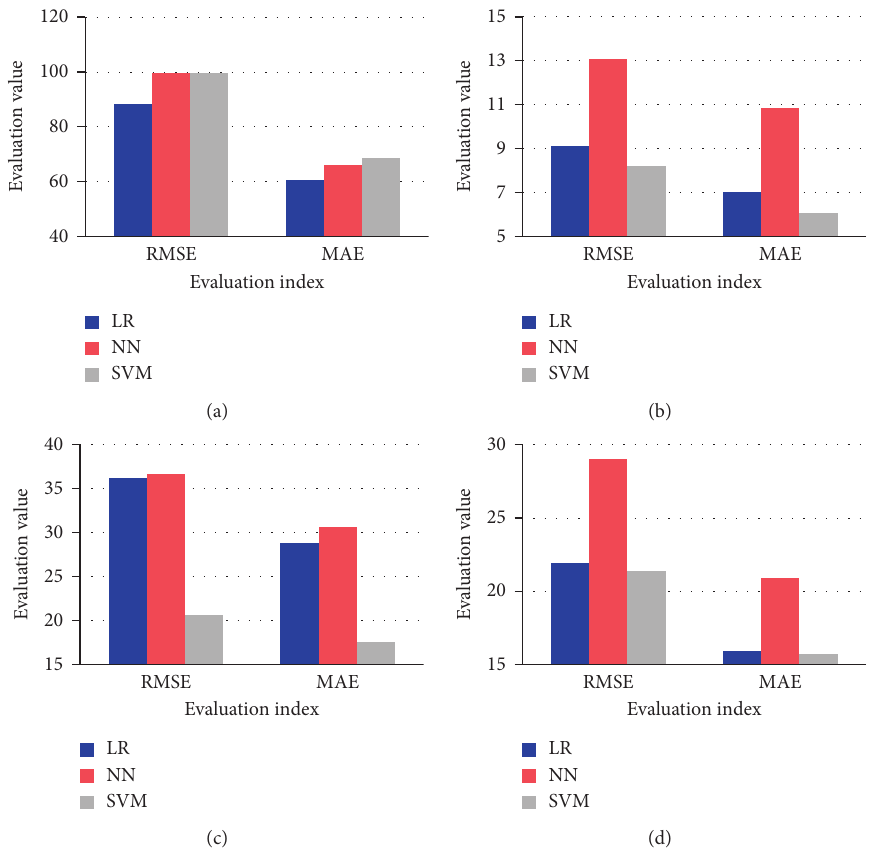
Figure 6: Comparison among the four prediction models using FM2. (a) Forecasting result of commercial parks using FM2. (b) Forecasting result of office parks using FM2. (c) Forecasting result of small-scale parks using FM2. (d) Forecasting result of medium-scale parks using FM2.